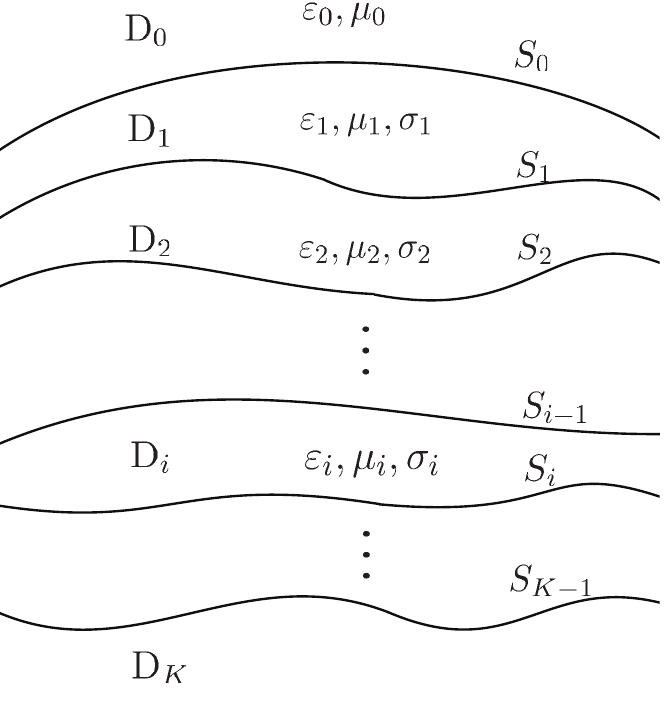
Figure 1. K -layered dissipative medium